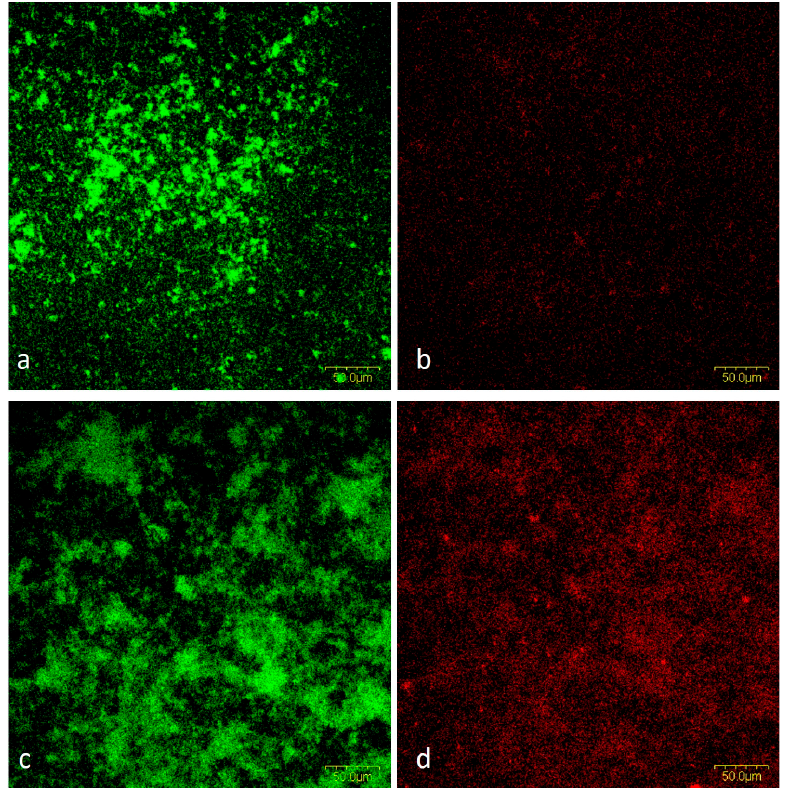
Figure 7. Illustration of the structural organization of EPS (red) and live bacterial cells (green); ( a ) SYTO-9 stain in salivarius mixed bio fi lm; ( b ) SYPRO Ruby Bio fi lm Matrix Stain in salivarius mixed bio fi lm; ( c ) SYTO-9 stain in non-salivarius mixed bio fi lm; ( d ) SYPRO Ruby Bio fi lm Matrix Stain in non-salivarius mixed bio fi lm; Magni fi cation 20×.